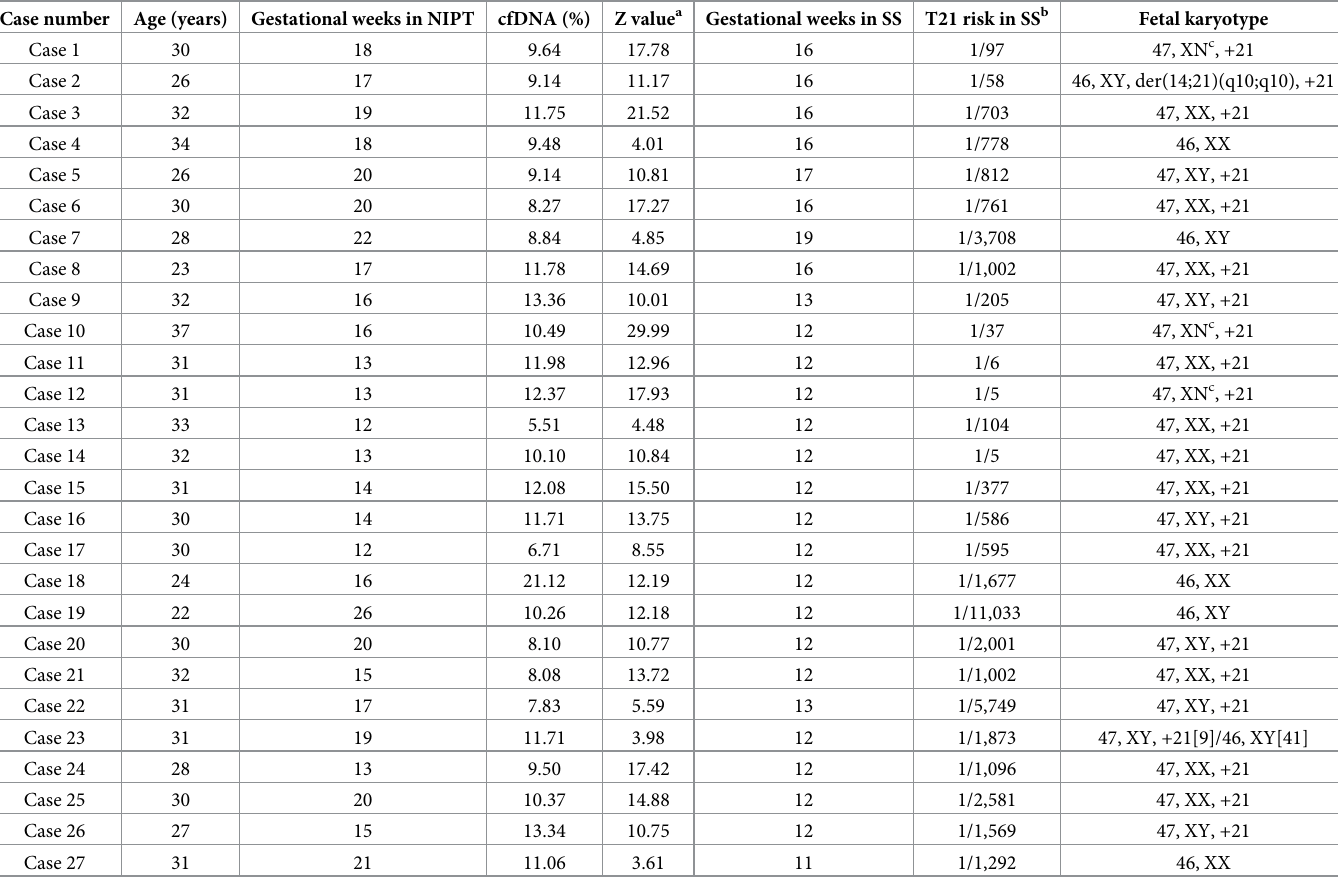
Table 3. Serum screening and fetal karyotype of cases at high risk in noninvasive prenatal